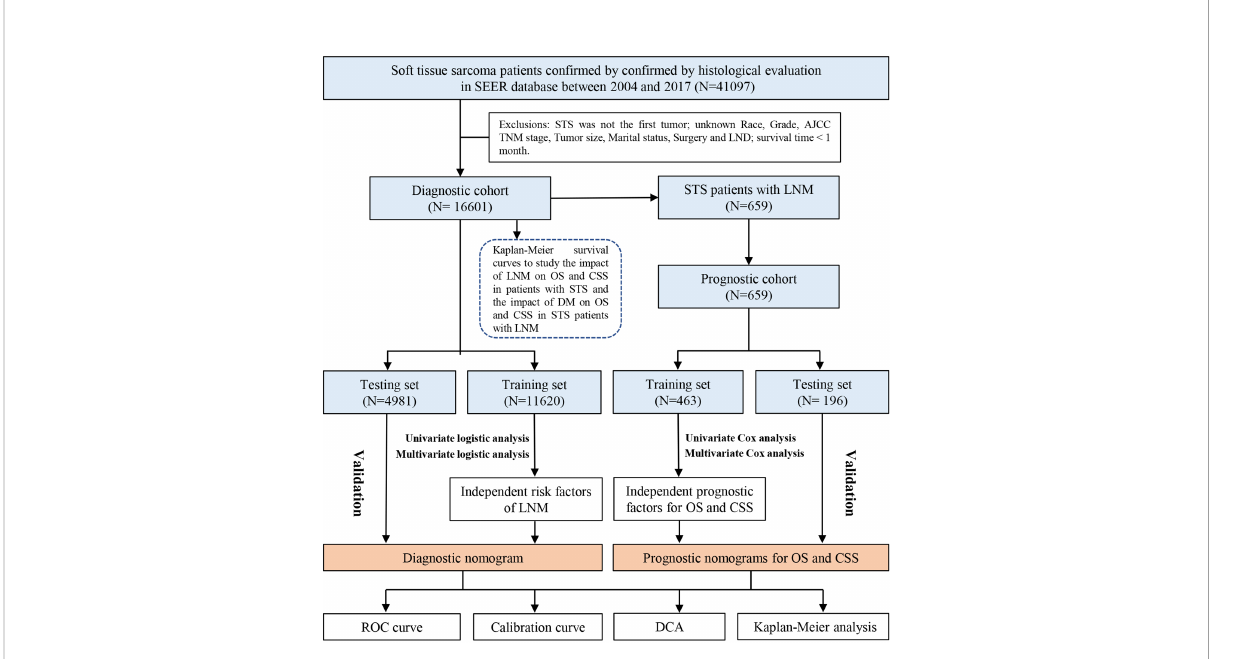
FIGURE 1 The detailed selection process of patients and work fl ow of